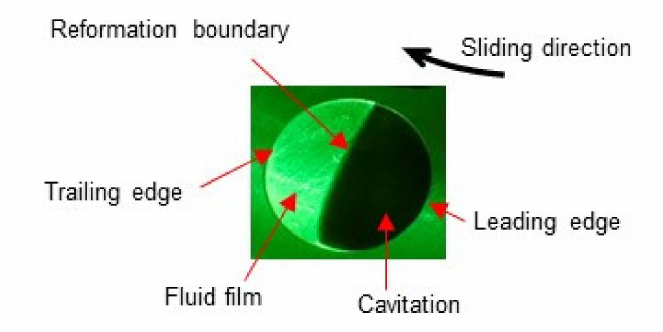
Figure 7. Example of cavitation occurred within a